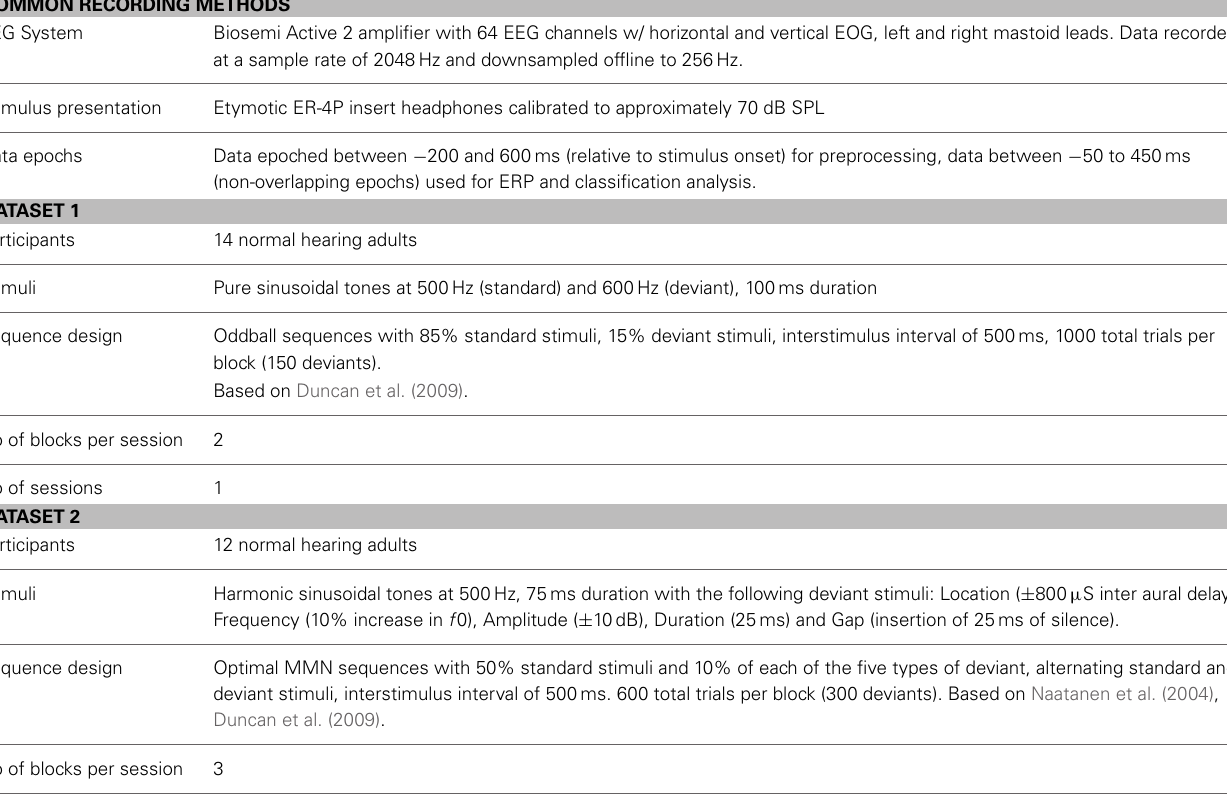
Table 1 | Summary of Datasets 1 and